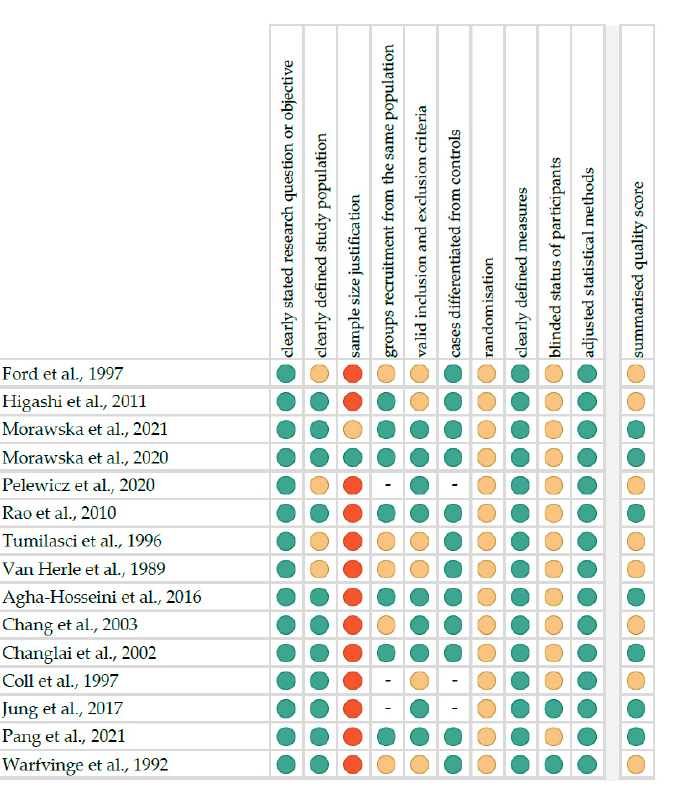
Figure 1. Quality assessment, including the main potential risk of bias (risk level: green—low, yellow—unspecified, red—high; quality score: green—good, yellow—intermediate, red—poor) [24–38].